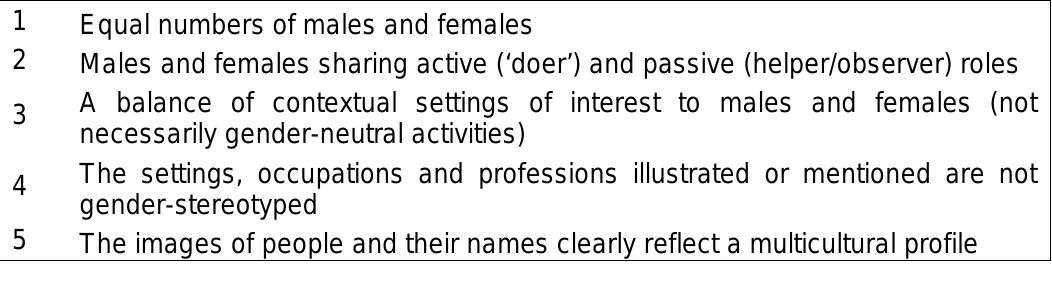
A checklist for a gender-equitable mathematics textbook (adapted from Forgasz, 1996: